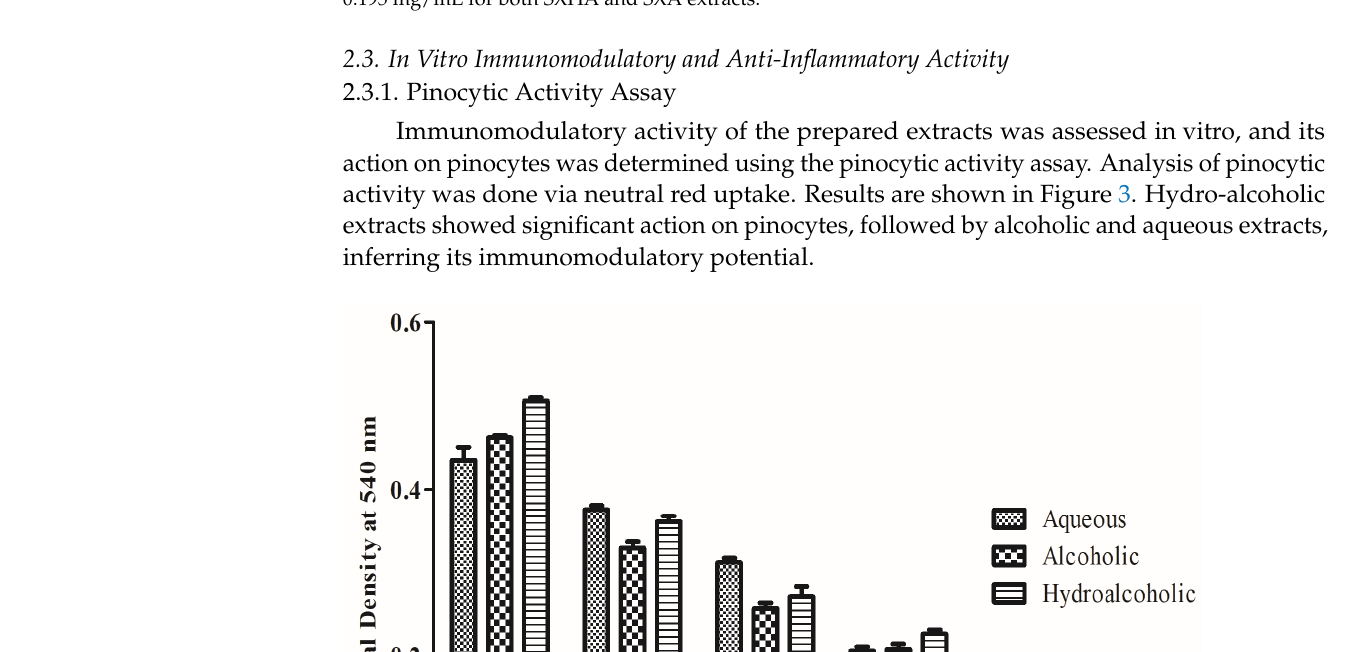
Figure 2. Assessment of free radical scavenging activity using the DPPH assay (% DPPH inhibi- tion).